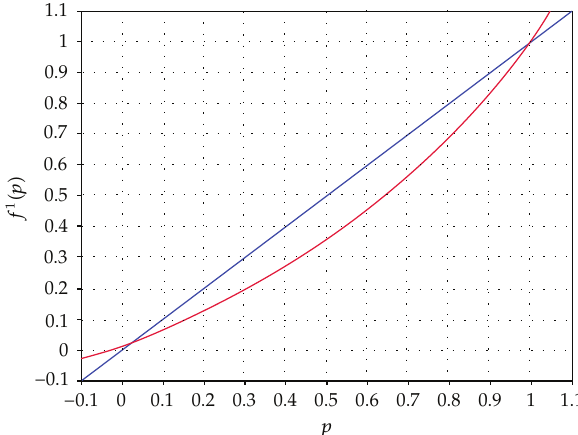
Figure 3: Phase diagram. Replicator dynamics—Example